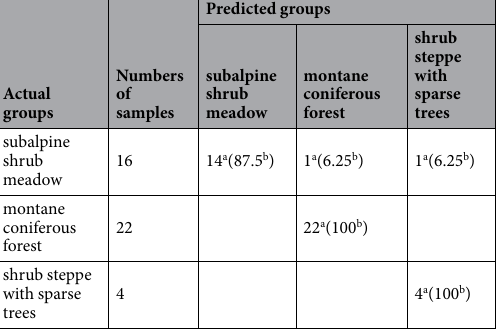
Table 2. Discriminant analysis results of the surface samples. Samples numbers: 42. Misclassified samples numbers: 2. Percentage of correctly classified samples: 95.2%. a Surface samples numbers classified as that group. b Surface samples percentage of classified as that